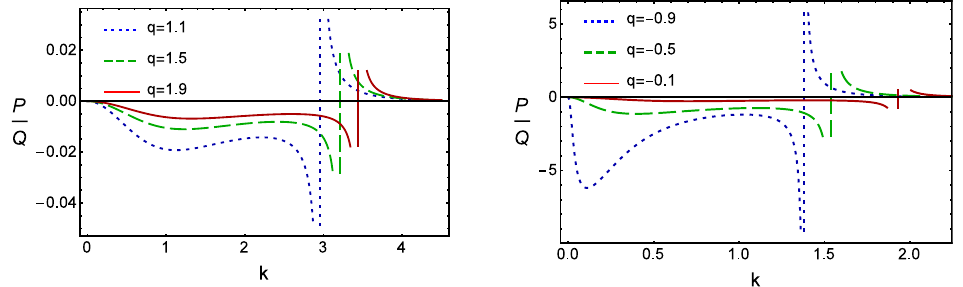
Figure 1. Plot of P / Q versus k for different values of positive q ( left panel), and negative q ( right panel) when α = 1.0, δ = 0.0003, µ i = 1.4, µ p = 0.3, and σ = 1.